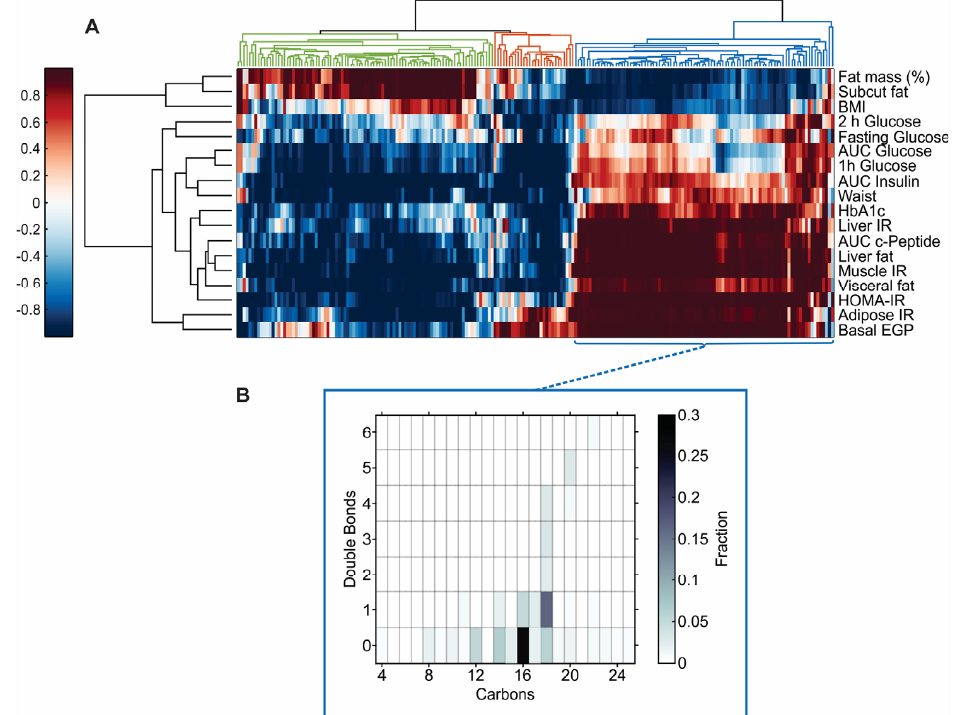
Figure 2. Omics patterns of plasma lipidomics and metabolomics in individuals living with obesity. ( A ) Hierarchical clustering of metabolic phenotypes by plasma lipidomics and metabolomics. ( B ) Chain length (number of carbons) and number of double bonds in the TAGs represented in the blue cluster. In panel A, the clinical variables are shown in the rows with the metabolomics and lipidomics variables in the columns. The H = (1 − p ) sign ( R ) value is shown as a heatmap with the color indicating the significance and direction of the correlation (Spearman) (i.e., red positive, blue negative and the darker the color the more significant p Value). The variables are clustered firstly according to the clinical variables (rows) with the hierarchical cluster tree shown as a dendrogram on the left. The p ‐ value data in the columns (metabolomic and lipidomic variables) were then hierarchically clustered with the dendrogram shown at the top of the heatmap. In panel B, the color indicates the fraction of the total number of fatty acids (n = 207 FAs). Complete data were available for all variables other than the abdominal MRI data (n = 59) and AUC of insulin and c ‐ peptide (n = 57 and n = 59, respectively).